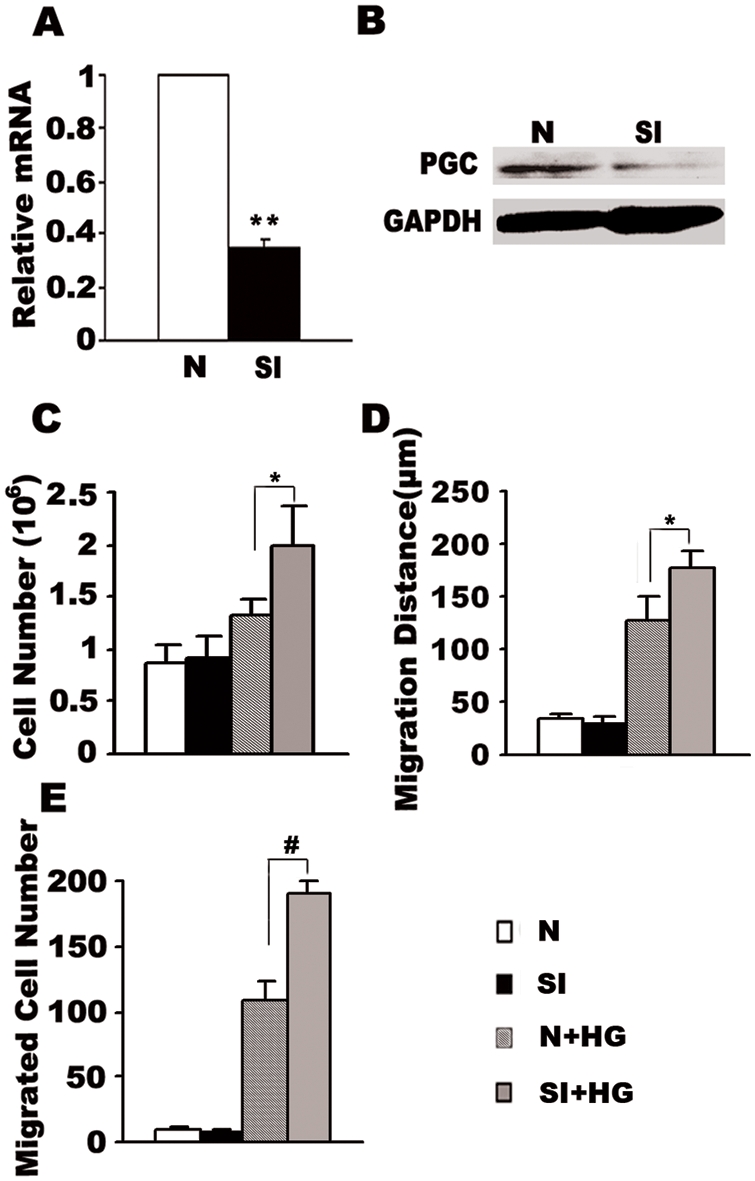
Knock-down of PGC-1α accelerated high glucose-induced VSMC proliferation and migration.VSMCs transfected with siRNA (SI) or the negative control (N), were either left untreated or stimulated with 15 mM gluoose (HG). The interference effect was assessed by quantitative PCR analysis and data were shown as the ratio of PGC-1α/β-actin (A), **P<0.01compared with the negative control group (N). 120 µg total proteins from VSMCs were assayed for Western blot with PGC-1 antibody to confirm the interference effiency (B). Effects of decreased PGC-1α on high glucose-induced VSMC proliferation were determined by cell counting (C). VSMC migration was determined by wound healing (D) and transwell analysis (E). Individual data points in this figure represents the mean±S.E.M (n = 6). *P<0.05, #P<0.001 compared with the control group (N+HG).